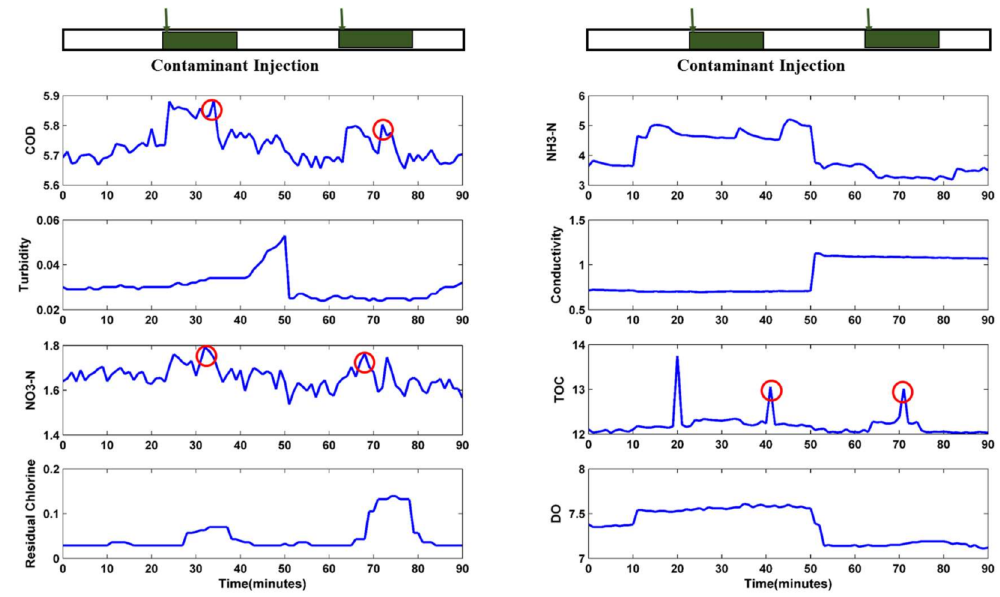
Figure 7. Sensor responses for potassium ferricyanide (concentrations: 0.5 and 1.0 mg L − 1